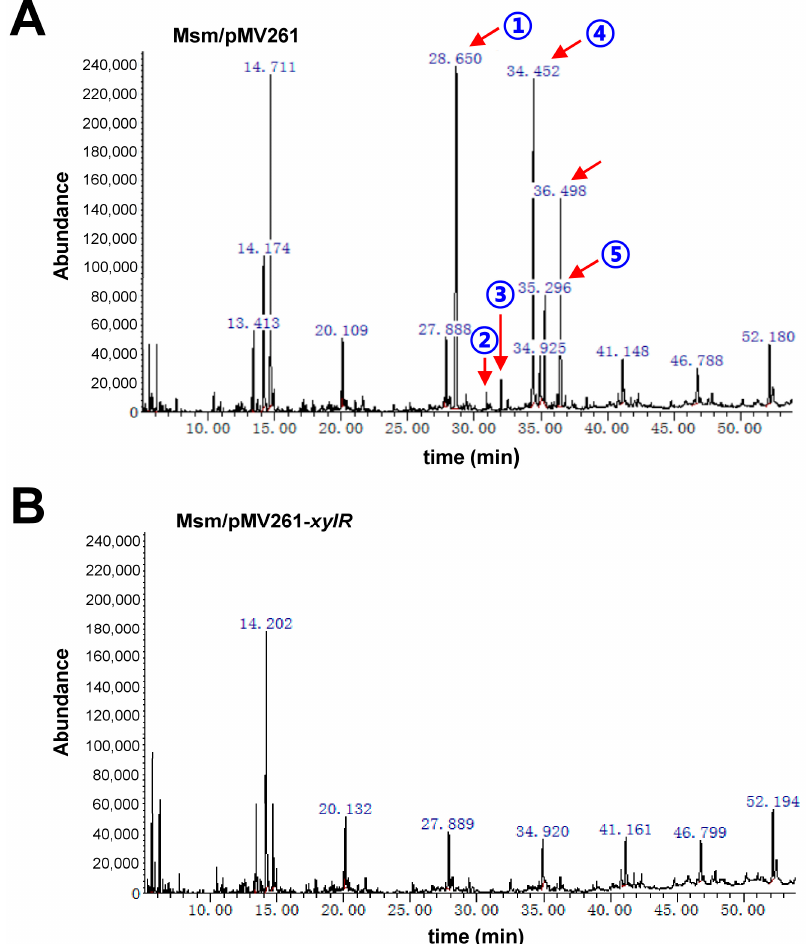
Figure 4. GC/MS assays for detecting the lipids of M. smegmatis strain. The six lipids identified with significant changes are indicated by arrows. The levels of lipids in the xylR- overexpression strain ( B ) were lower than in the Msm/pMV261 strain ( A ).